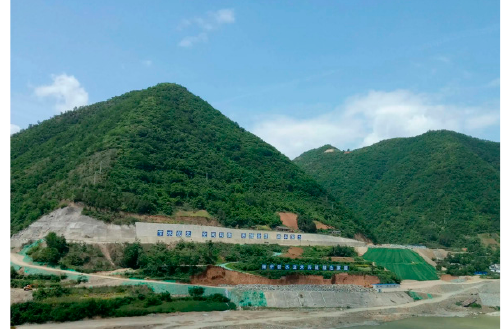
Figure 1. Original landform.